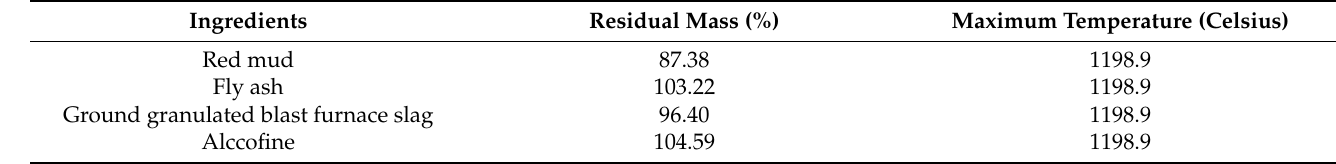
Table 6. Thermogravimetric analysis of the